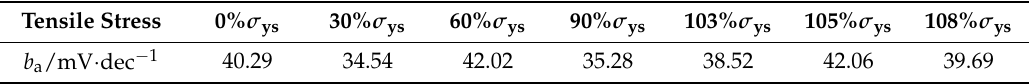
Figure 5. Potentiodynamic polarization curves of X80 steel exposed to 3.5 wt% NaCl aqueous solution with saturated CO 2 at 30 °C under different elastic and plastic tensile stress. Table 2. Anodic Tafel slope obtained by Tafel fitting of polarization curves for X80 in 3.5 wt% NaCl aqueous solution with saturated CO 2 at 30 °C under different elastic and plastic tensile stress.